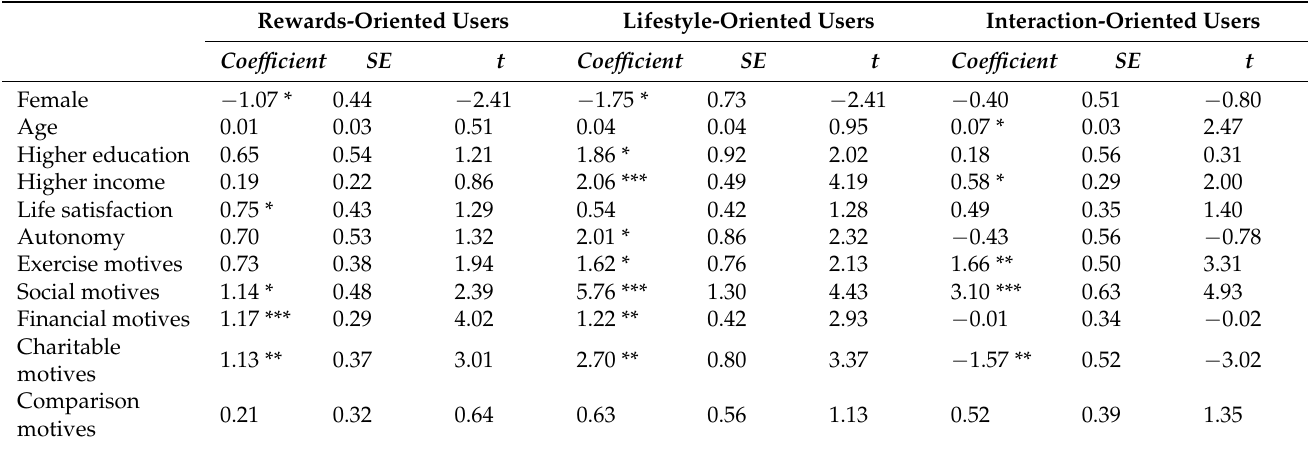
Table 5. Covariate analysis with light users as the referent